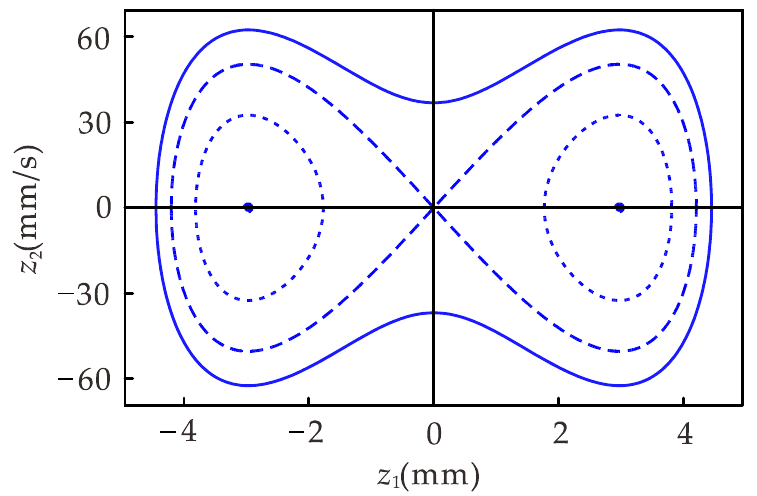
Figure 5. Equilibrium point bifurcation diagram. Figure 6a gives the RMS voltage versus load resistance for the harvester. The RMS voltage increases as the load resistance increases and eventually increases to saturation. Figure 6b shows the corresponding power versus load resistance, where the power first increases and then decreases with the increasing load resistance. It can be observed from Figure 6 that torque affects voltage and power. Figure 7 shows the relationship between the relative error of the output power and the load resistance without considering the torque. The results show that when the load resistance is small and the distance between permanent magnets is large, not considering that the torque causes a large error, and the maximum error can reach 18.96% when d = 24 mm.